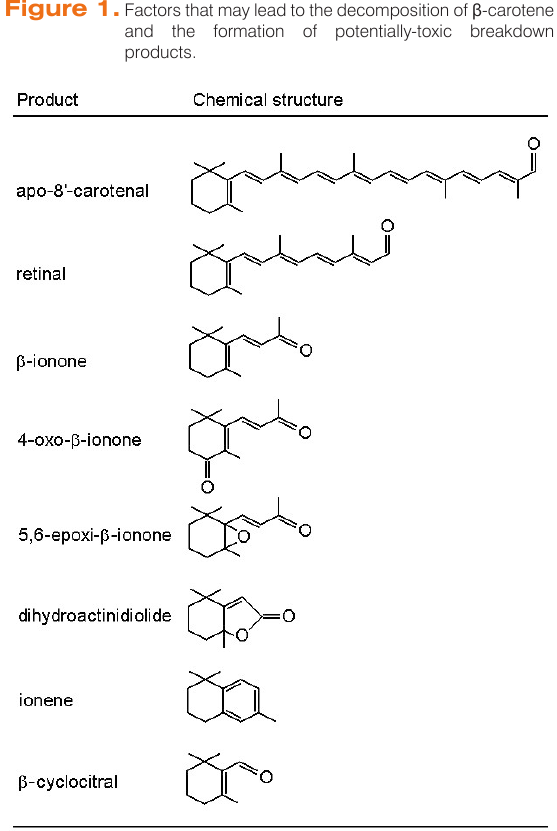
Figure 2. Products obtained by treating β -carotene with HOCl/ - OCl or activated neutrophils in vitro